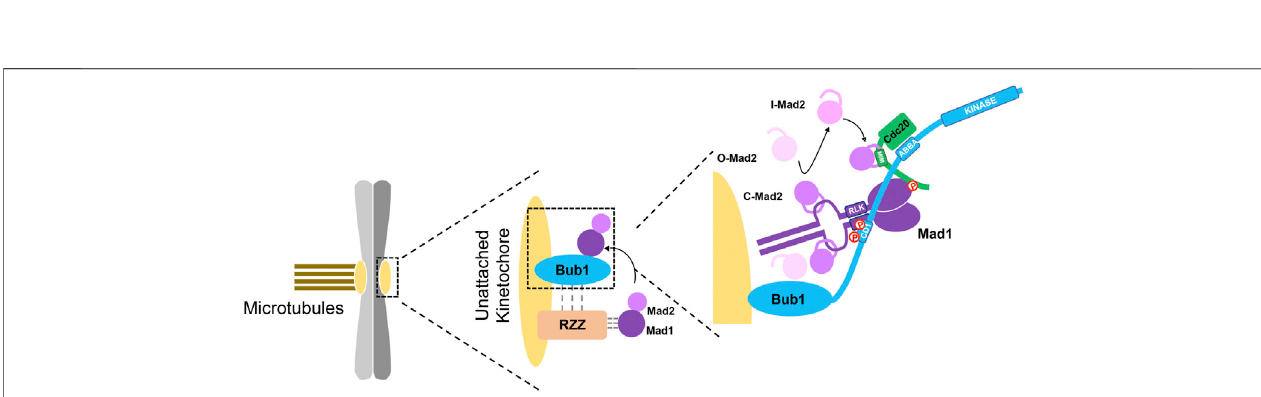
FIGURE 3 | Bub1 activates SAC via interactions with multiple checkpoint proteins. The cartoon describes the interactions of Bub1 with Mad1, RZZ and Cdc20 in activating SAC signaling on unattached kinetochores. The left part shows a pair of chromatids with one kinetochore attached by microtubules and the other one unattached. The middle part shows recruiting Mad1/Mad2 onto kinetochores through two distinct and integrated pathways, Bub1-Mad1 and RZZ-Mad1. The dashed lines indicates dependency of RZZ on Bub1 and Mad1 on RZZ whereas the physical interactions have not been con fi rmed. RZZ binding with Mad1 promotes the binding between Bub1 and Mad1, which further catalyzes the formation of Mad2-Cdc20 complex as shown in the right part. Simultaneous interaction of Bub1 with Mad1-Mad2 and Cdc20 brings Mad2 close to Cdc20. The phosphorylation-mediated binding of the N-terminal Cdc20 with the C-terminal Mad1 exposes the Mad2 interacting motif on Cdc20 and facilitates the formation of Mad2-Cdc20 complex. The minor role of the kinase activity of Bub1 in SAC activation is not described here. Adapted from Lara-Gonzalez et al. (2021b).